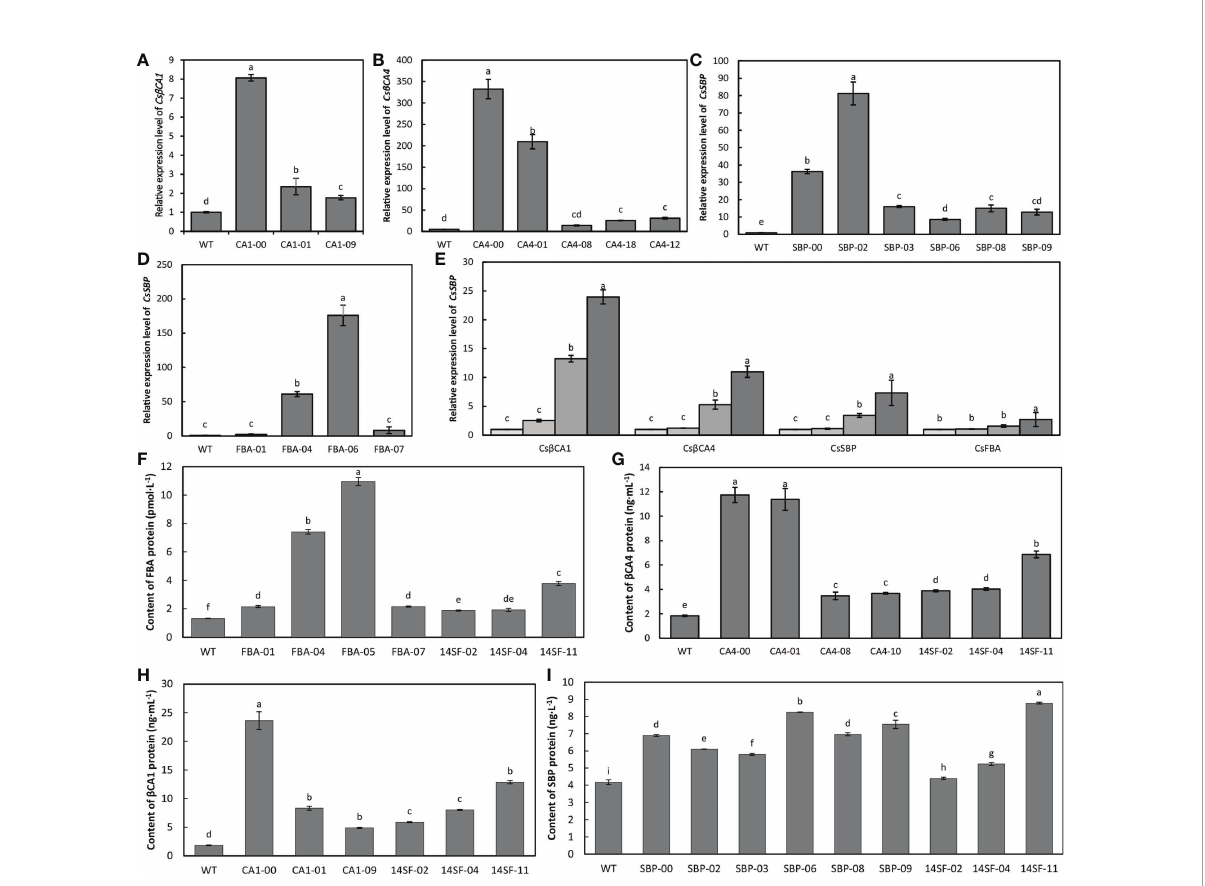
FIGURE 4 Expression analysis of transgenic lines. (A – D) qRT-PCR analysis of target gene transcript abundance in WT and transgenic cucumber lines. (E) qRT-PCR analysis of four genes in WT and 14SF lines. (F – I) ELISA analysis of target gene coding protein content of Cs b CA1 (F) , Cs b CA4 (G) , CsSBP (H) , and CsFBA (I) in different transgenic lines. Small letters in each fi gure represent signi fi cant differences among samples by Student ’ s t- test (P <